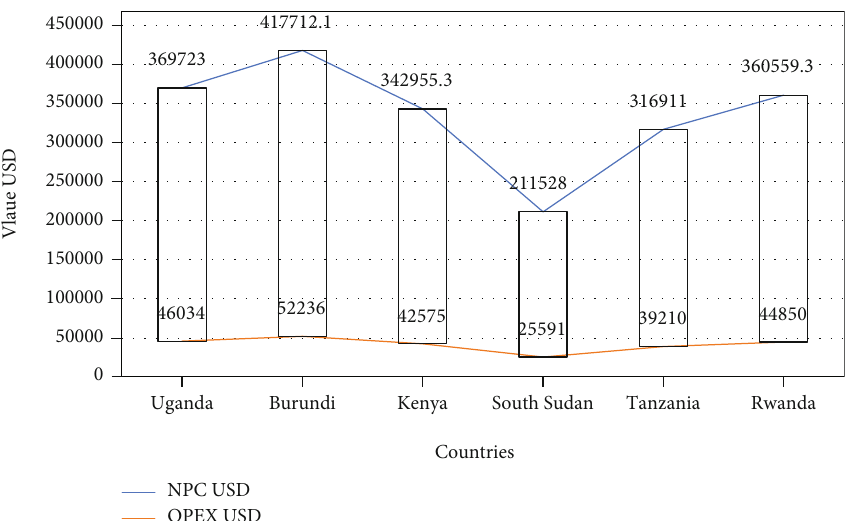
Figure 8: NPC and OPEX with diesel